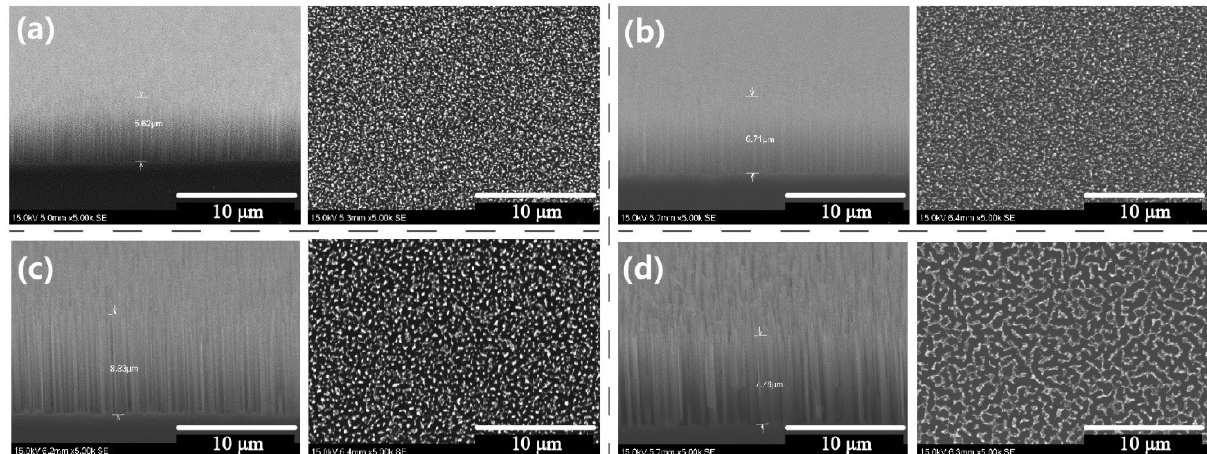
Figure 3. Photograph and SEM images of the silicon nanowires formed through longer etching duration and the varying Au nanoparticle sizes and etching loops. ( a ) Tilted view and top view of the nanowire formed through 160 etching loops, the particle mask is formed by 4 nm Au film; ( b – d ) tilted view and top view of the nanowires formed through 160 etching loops; the particle masks are formed by 6, 8, and 10 nm Au film, respectively.